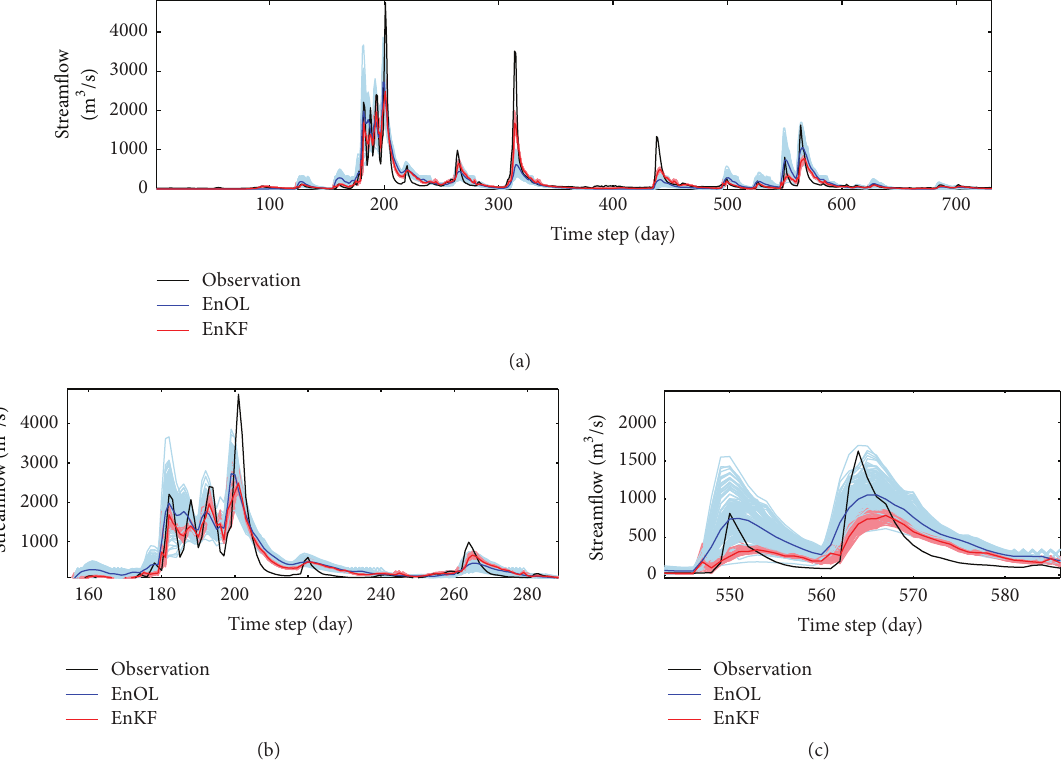
Figure 13: Comparison of the simulated streamflow by EnKF and EnOL at the basin outlet (HB station) in real data application: (a) the whole period from Jan. 1, 1996 to Dec. 31, 1997; (b) and (c) details of the period with high flow. The light blue and red lines represent the ensemble members of EnOL and EnKF, respectively.